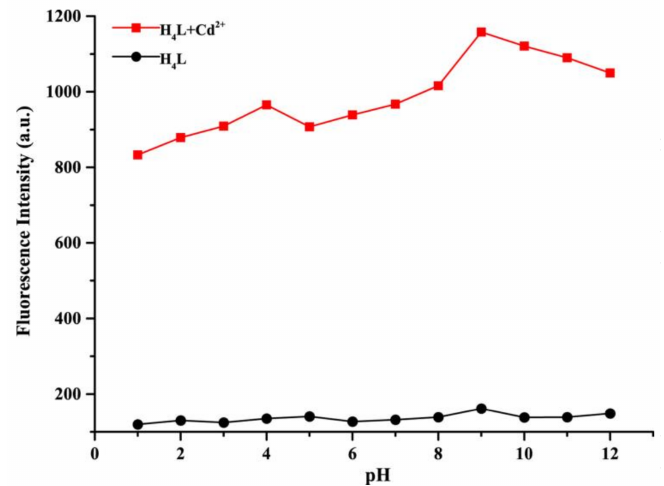
Figure 2. Changes in fluorescence intensity of H 4 L (c = 1 × 10 − 5 M) and Cd 2+ (c = 1 × 10 − 3 M) performed at different pH values at room temperature. (DMF/H 2 O = 9:1, v / v , λ ex = 323 nm, λ em = 495